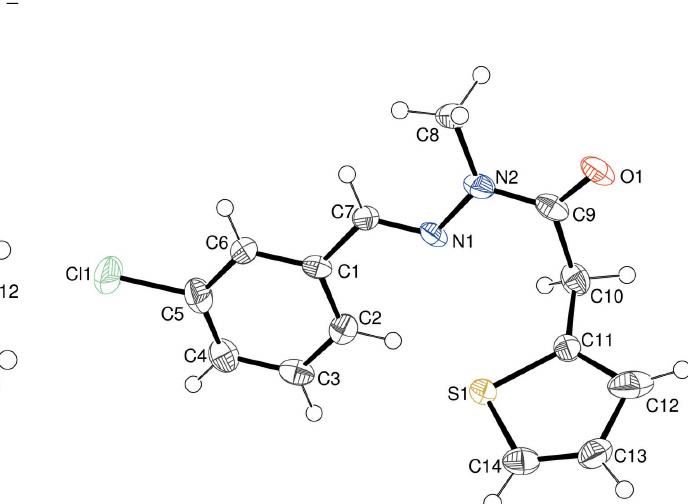
Figure 3 The molecular structure of (III), showing 50% probability displacement ellipsoids. Only the major orientation of the thiophene ring is shown.